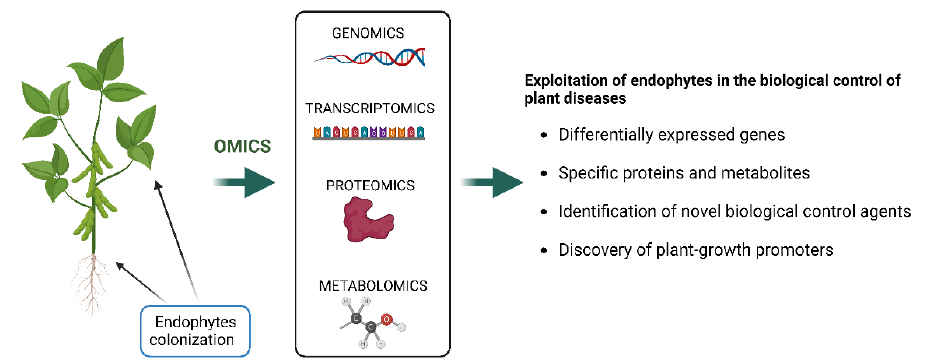
Figure 2. Schematic representation of omics approaches’ suitability for the exploitation of fungal endophytes for their application as biocontrol agents and plant-growth promoters. The figure was created with BioRender.com (accessed on 20 October 2022).